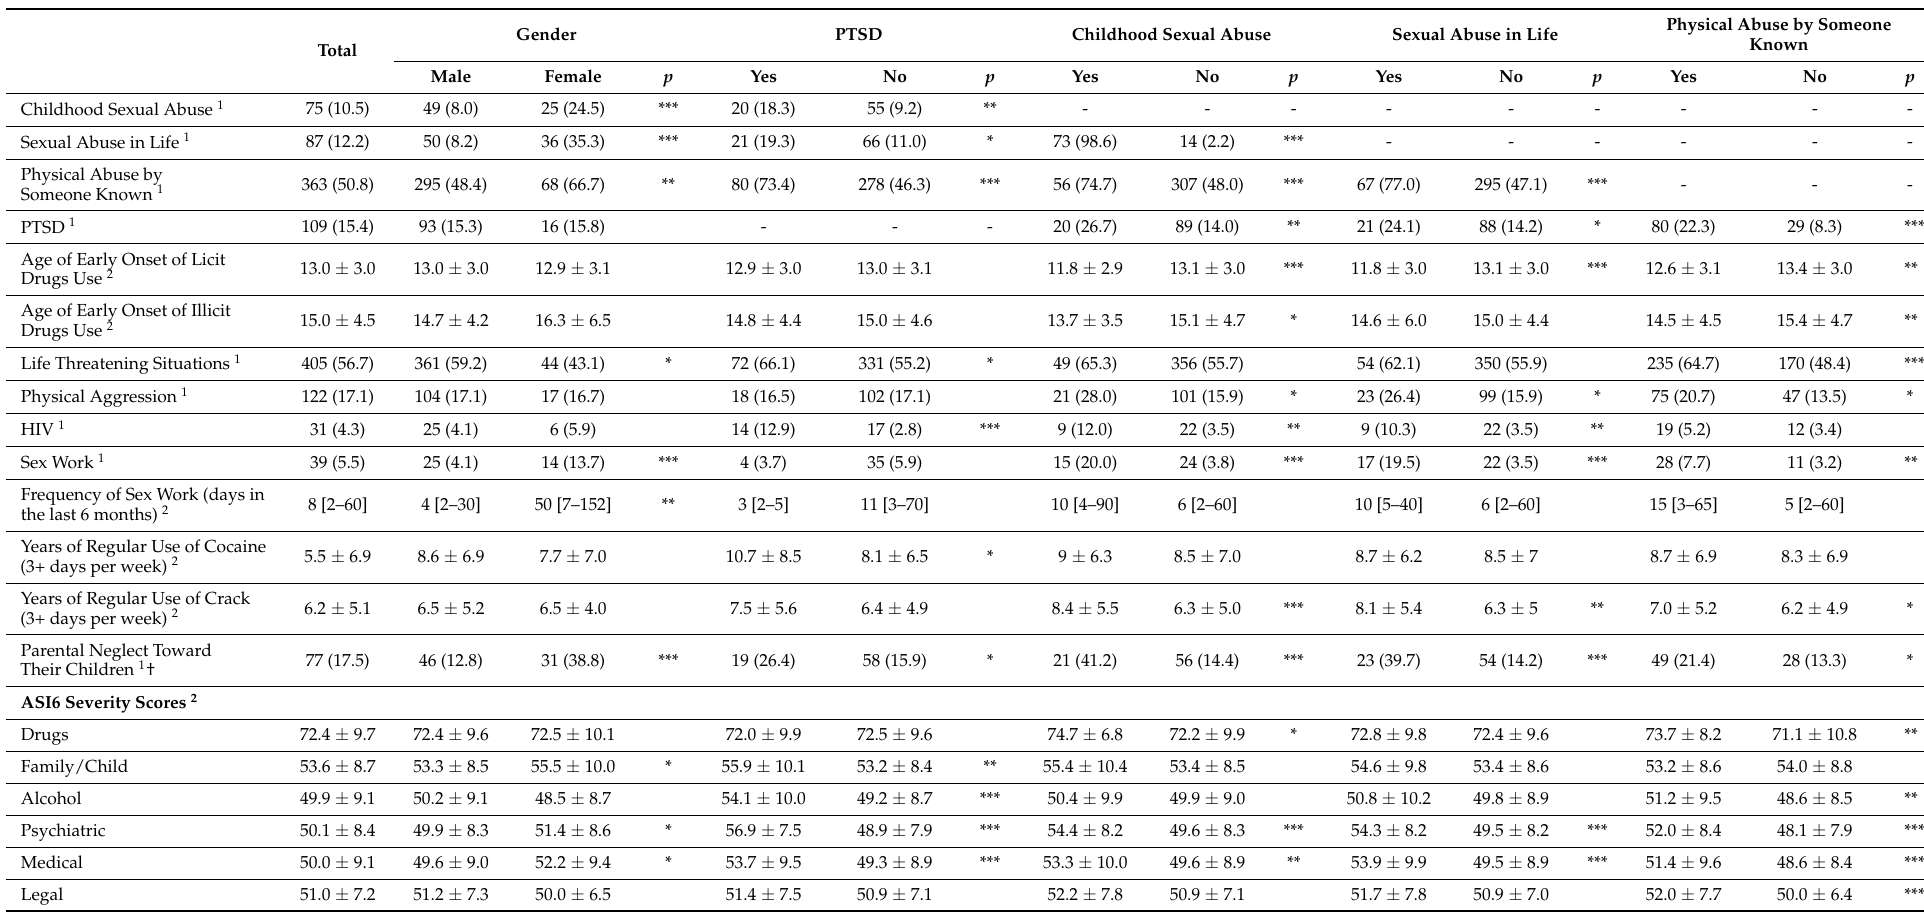
Table 2. Summary of Drug Use Patterns, HIV, Socials Outcomes, Parental Neglect and ASI-6 Severity scores by Gender, presence of PTSD, Childhood Sexual Abuse, Sexual Abuse in Life and Physical Abuse among crack-cocaine outpatients